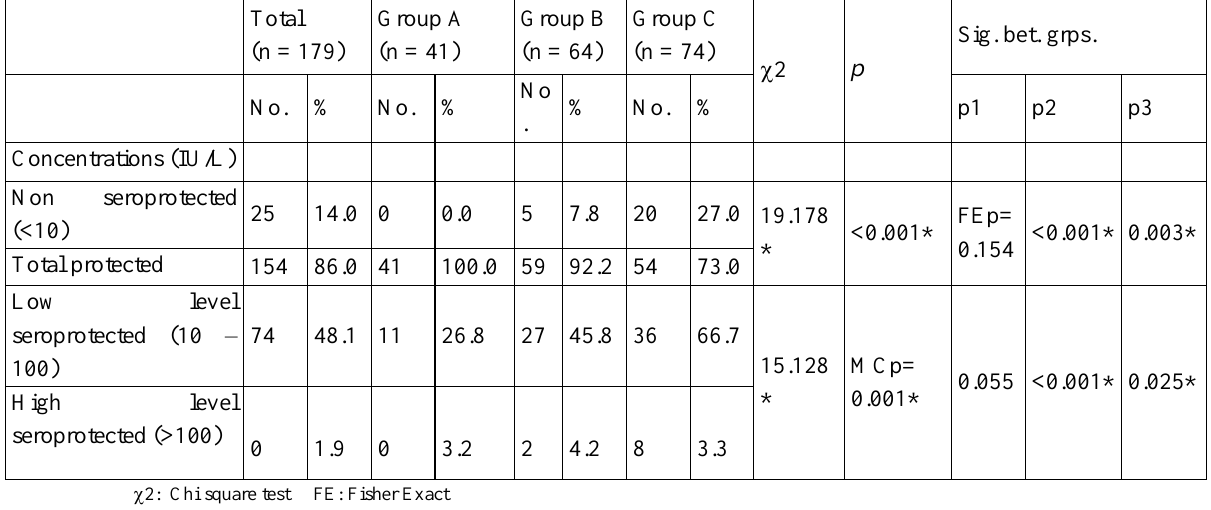
Table 1. Comparison between anti-HBs concentrations (IU/L) among the three studied groups.